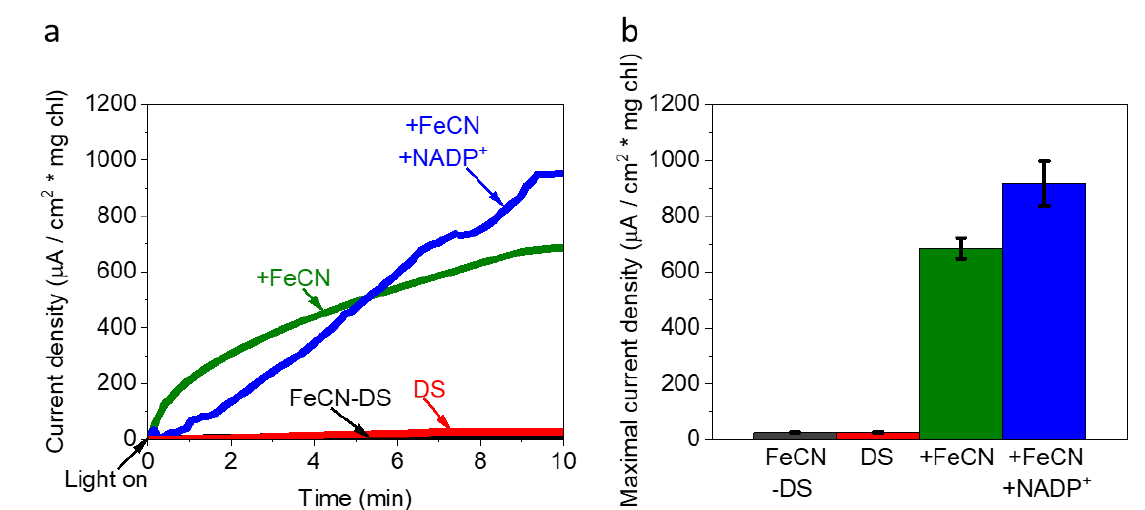
Figure 6. The addition of both FeCN and NADP+ produces a greater photocurrent. CA of FeCN, Ds, Ds with the addition of FeCN, and Ds with the addition of both FeCN and NADP + were measured. ( a ) CA of FeCN without Ds (black), Ds (red), Ds + FeCN (green), and Ds + FeCN + NADP + (blue). ( b ) Maximal current densities over 10 min of CA measurements. The error bars represent the standard deviation over three independent measurements.